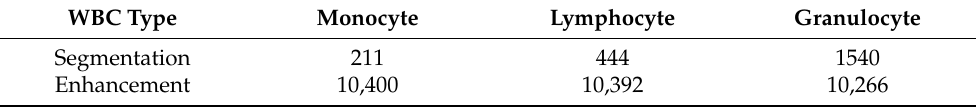
Table 1. Comparison of white blood cells (WBC) datasets before and after